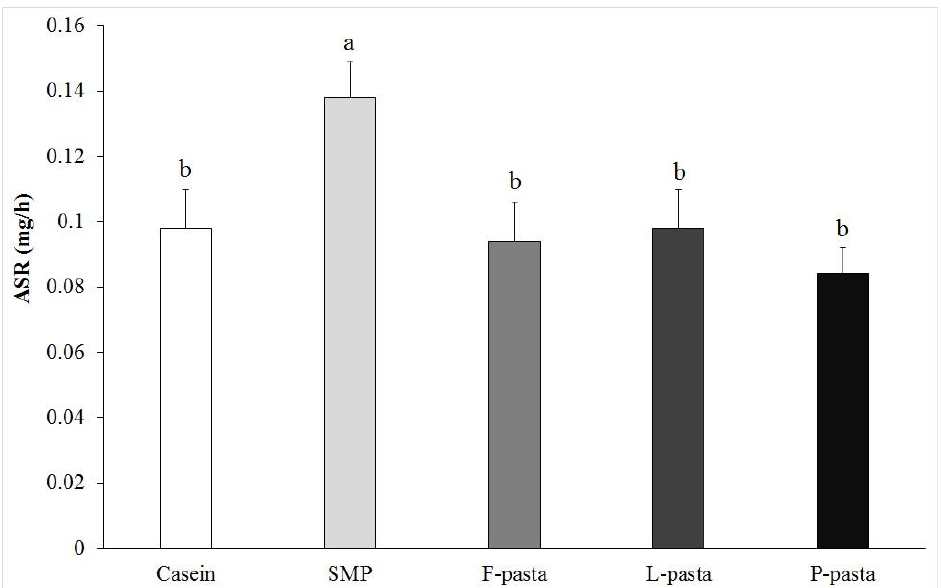
Figure 2. Protein synthesis rate in plantaris muscle in old rats after six weeks of diet; results are expressed as means ± SEM; means with the same letters are not significantly different ( p > 0.05). ASR = absolute synthesis rate; F-pasta = faba bean-enriched pasta; L-pasta = lentil-enriched pasta; P-pasta = split pea-enriched pasta; SMP = soluble milk proteins.